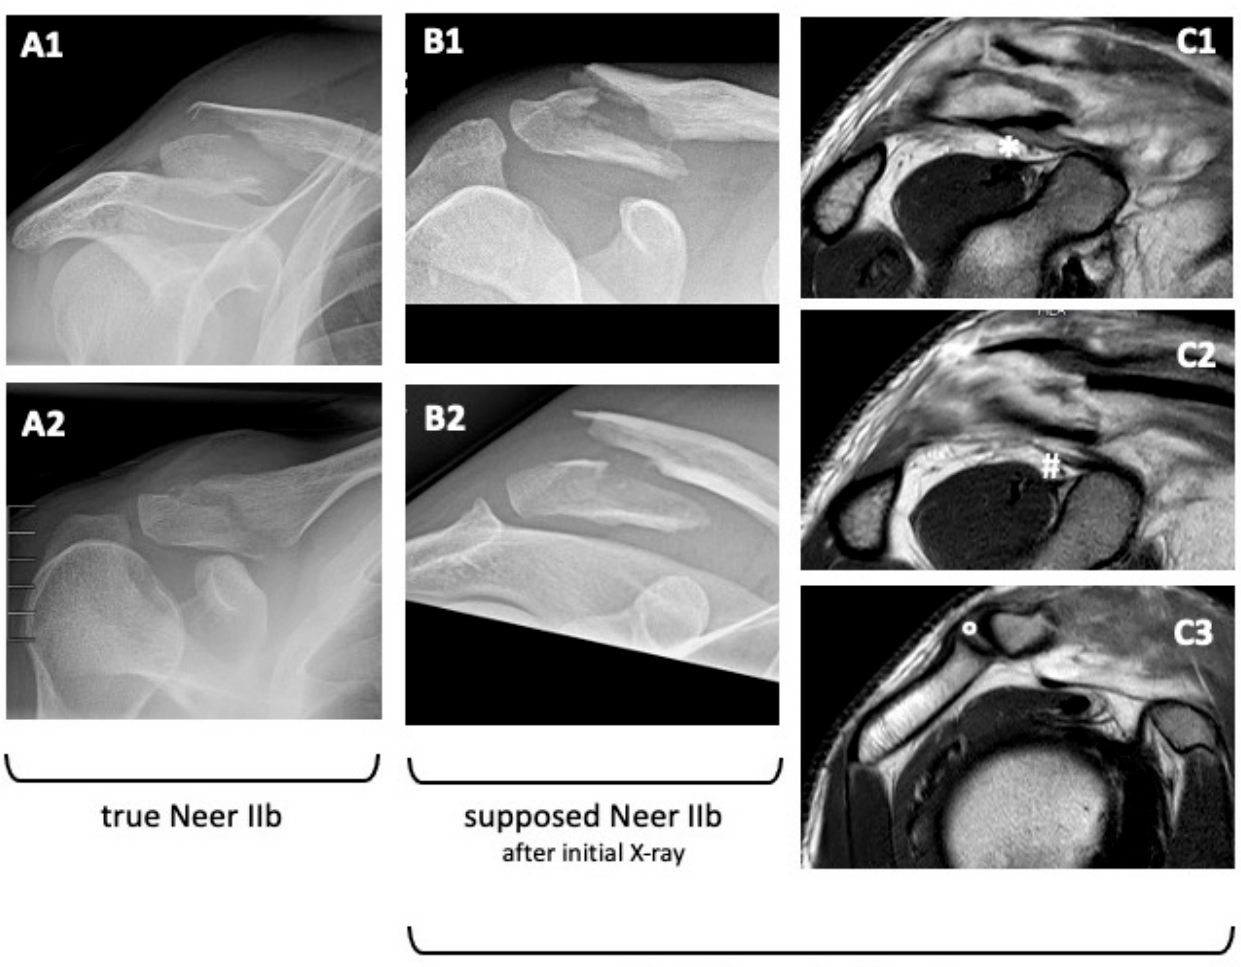
Figure 3. ( A1 , A2 ): Exemplary X-rays of a type IIb fracture according to the modified Neer classifi- cation. ( B1 , B2 ): X-rays of a fracture initially classified as Neer IIb (time [A]). ( C1 – C3 ): MRI shows an